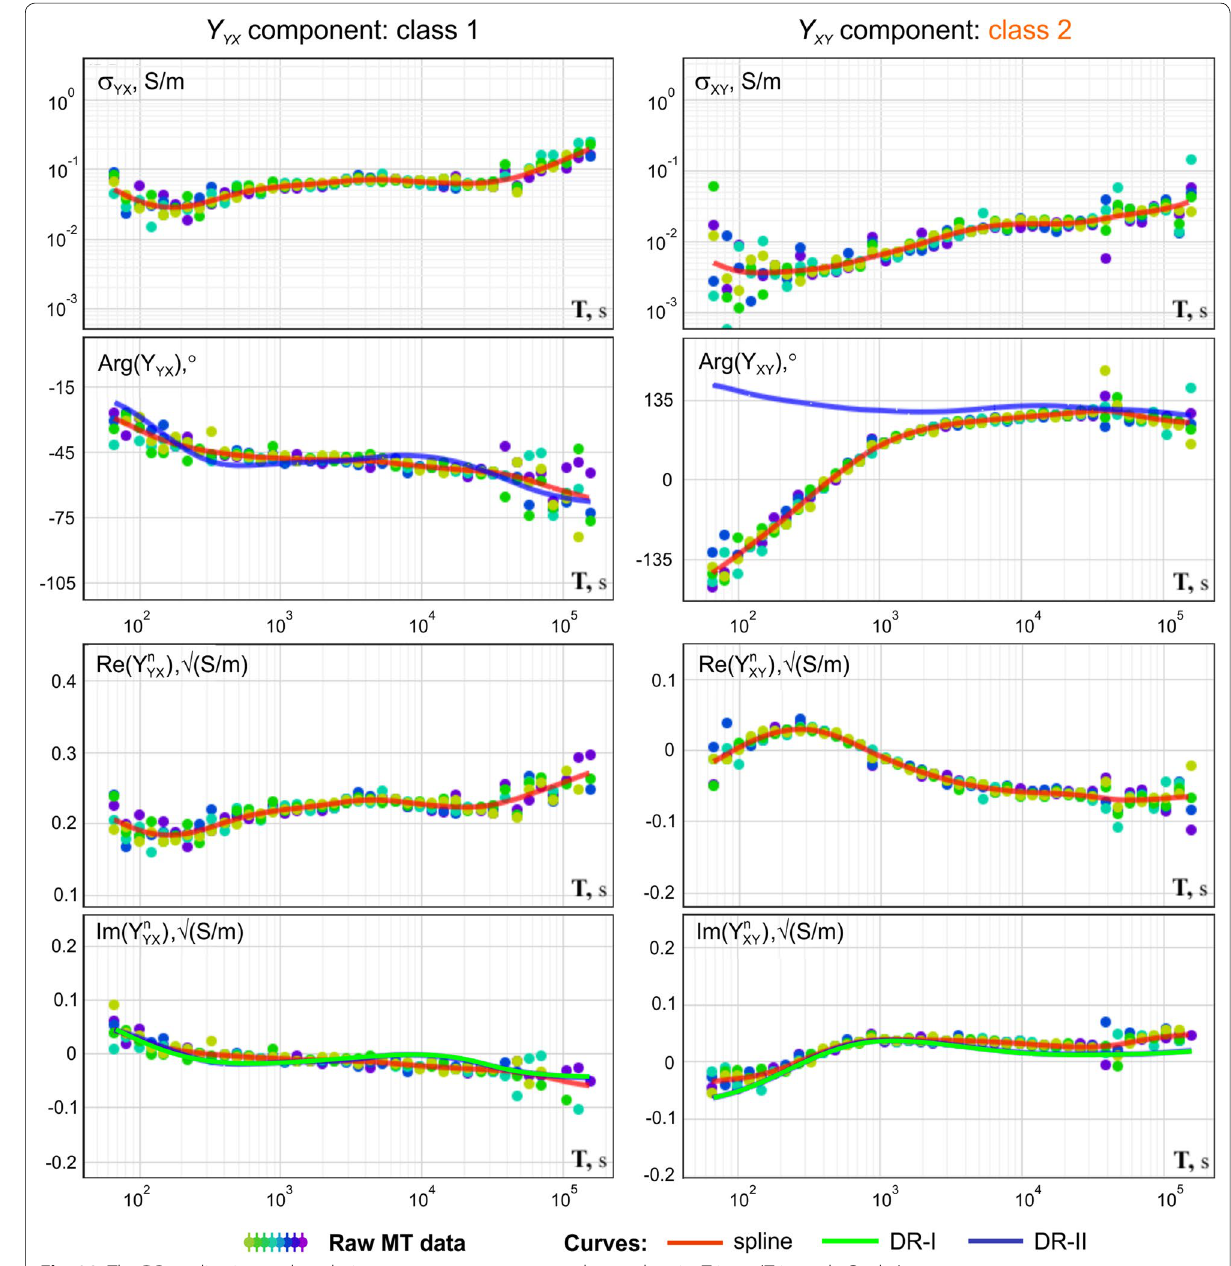
Fig. 20 The DR application to the admittance tensor components observed at site Tris-11 (Tristan da